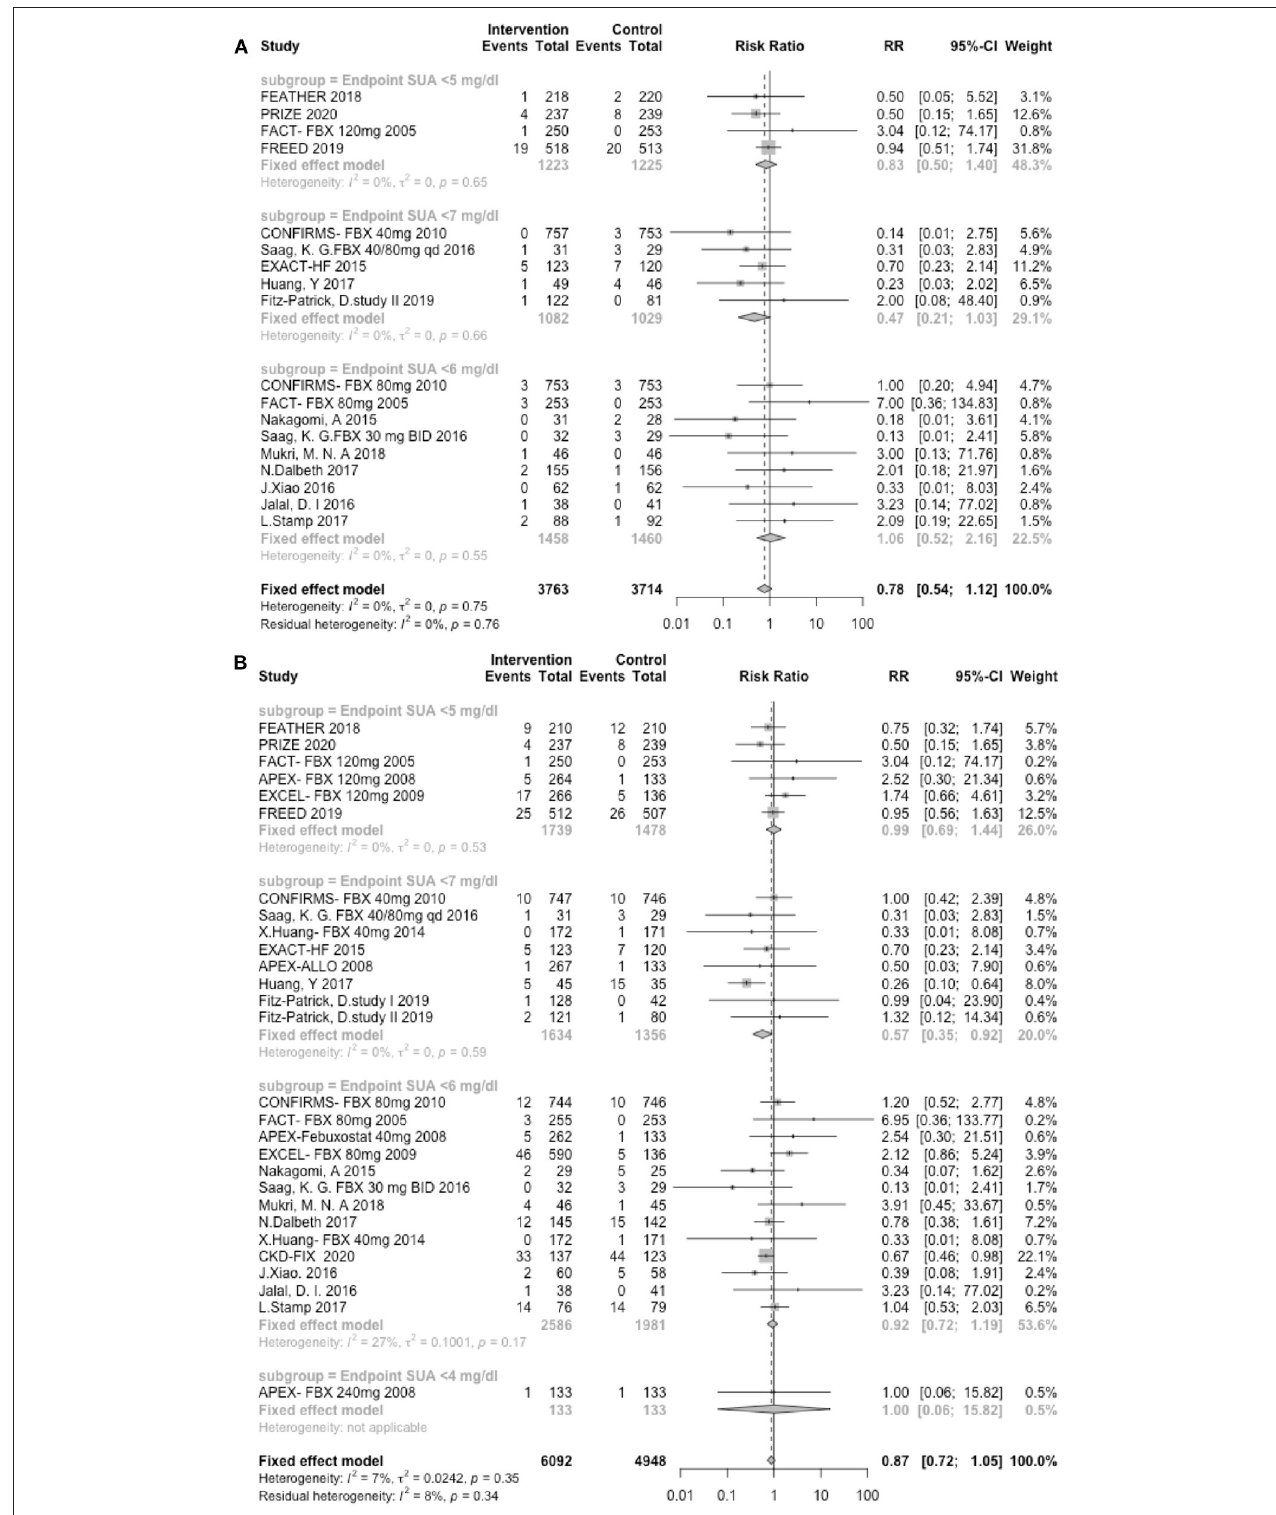
FIGURE 5 | UA endpoints. (A) Forest plots depicting the incidence of MACEs according to the UA endpoint stratification. (B) Forest plots depicting the incidence of CVEs according to the UA endpoint stratification. RR indicates risk ratios; CI indicates confidence interval.